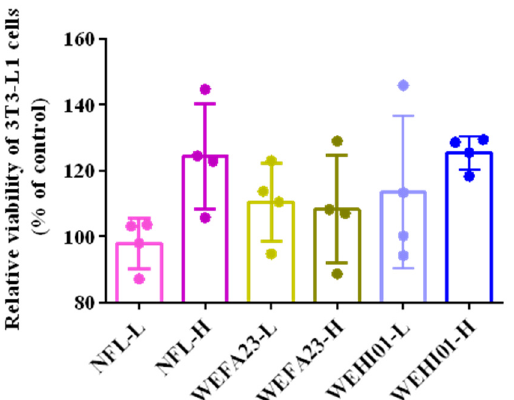
Figure 1. Effects of FLLS-WEFA23 and FLLS-WEHI01 on 3T3-L1 preadipocyte viability. Cells were treated with the Enterococcus fermented lotus leaf supernatant (FLLS) and non-fermented lotus leaf supernatant (NFLLS). Values are expressed as mean ± SD ( n = 4).